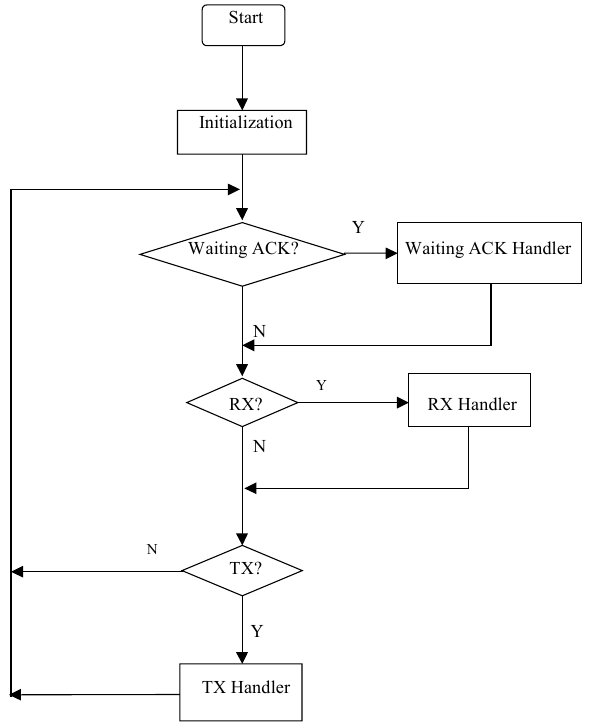
Figure 6. Flowchart showing (non host) node microcontroller operation. ACK